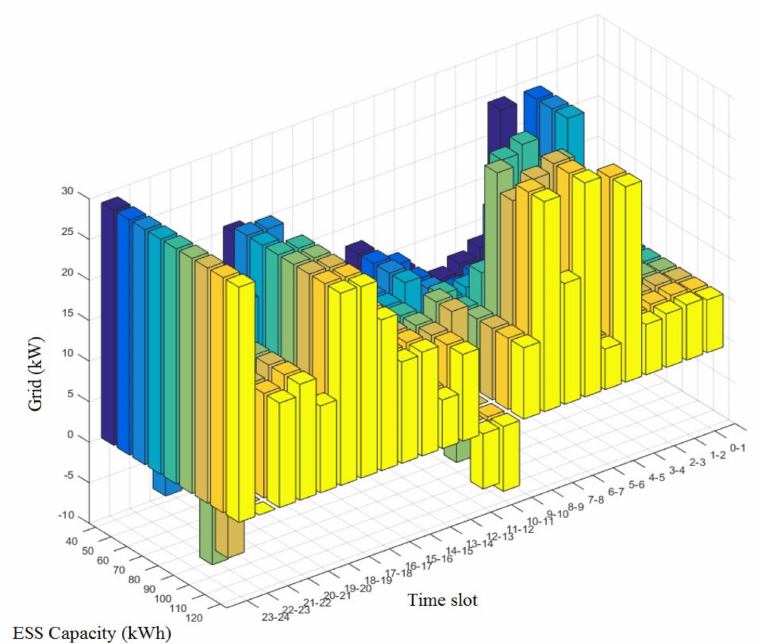
Figure 9. System power usage by ESS capacity